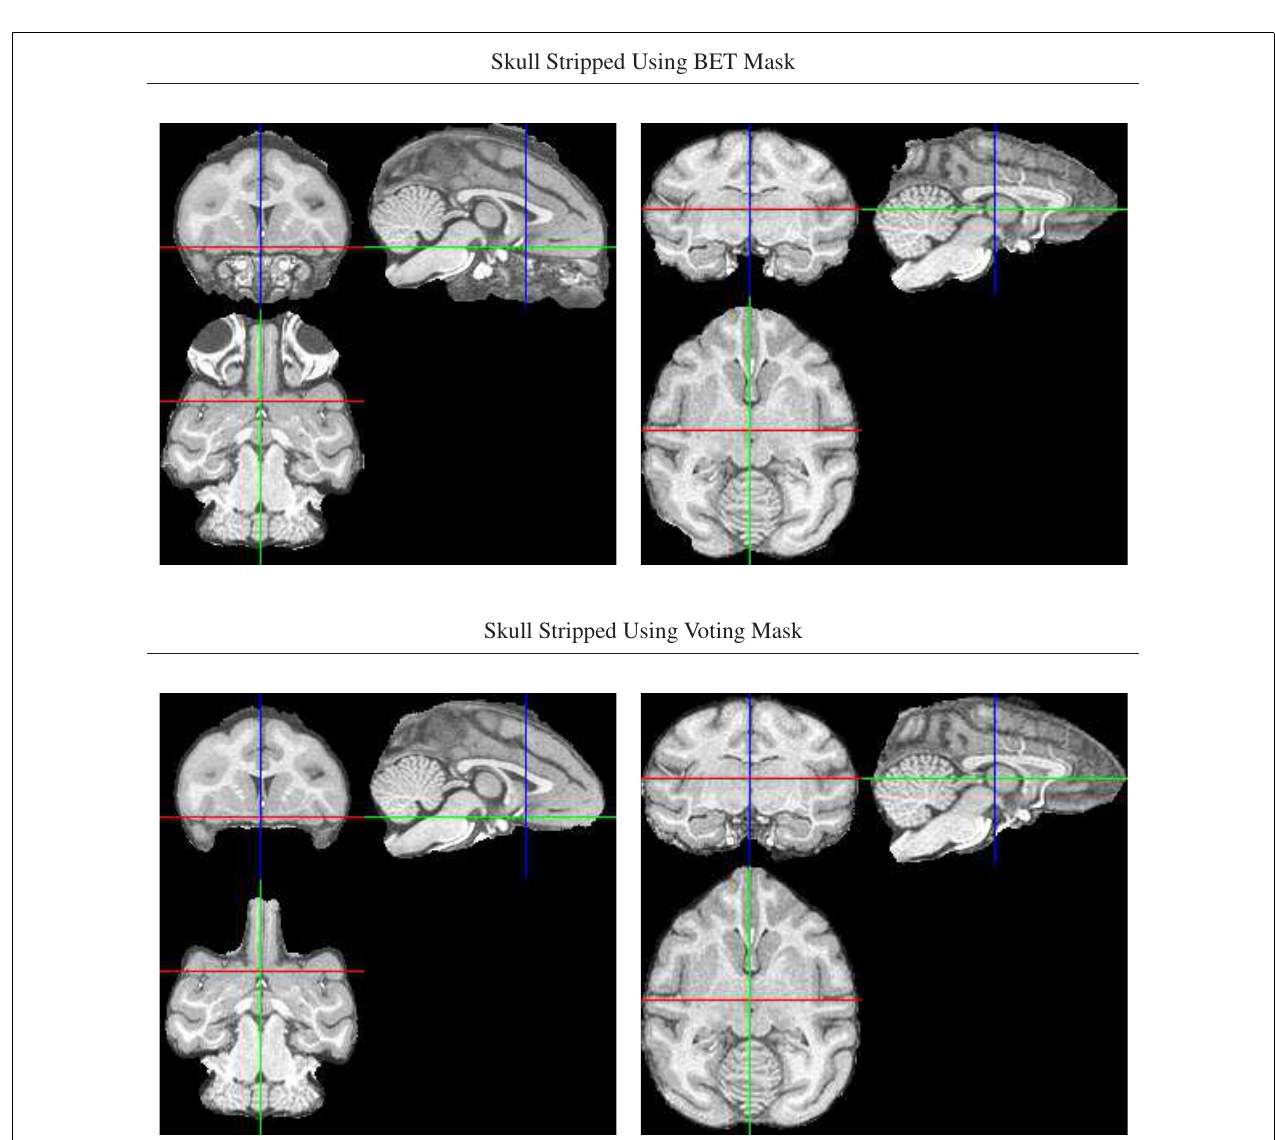
FIGURE 2 | Illustration of improved brain masks from voting compared with BET. Top row : images from two of the animals for which BET produced sub-optimal masks, one with large non-brain areas